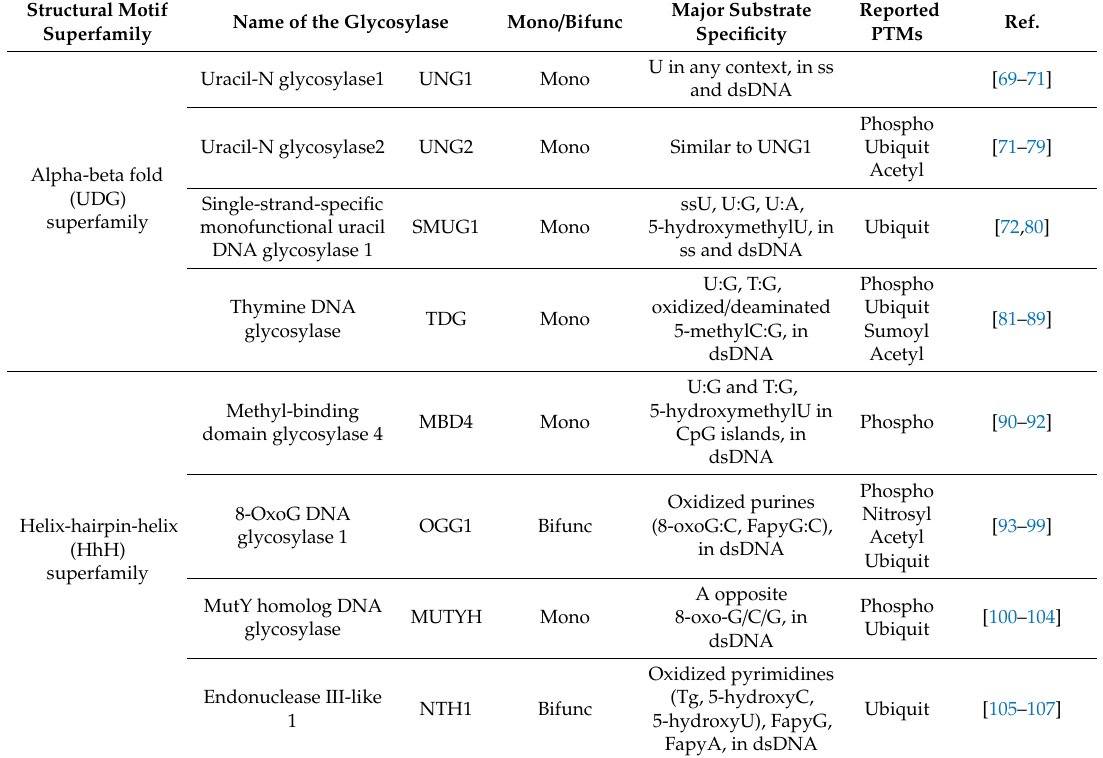
Table 1. Characteristics of human DNA